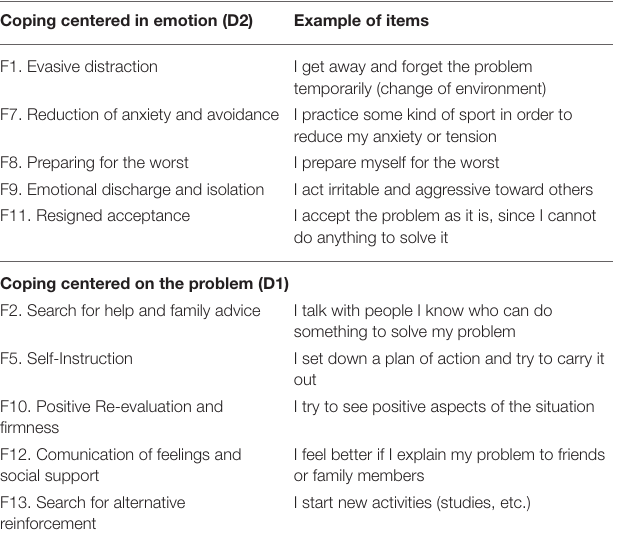
Table 1 | Types of coping strategies and examples of